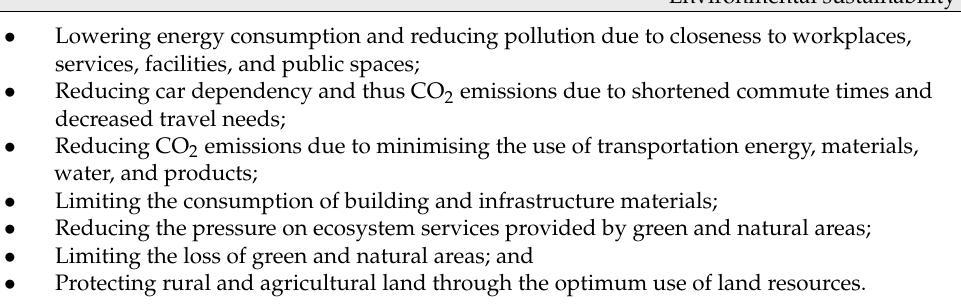
Environmental sustainability